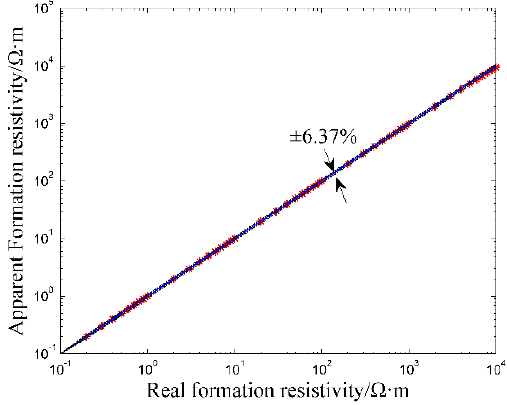
Figure 11. Resistivity measurement result of the logging instrument.